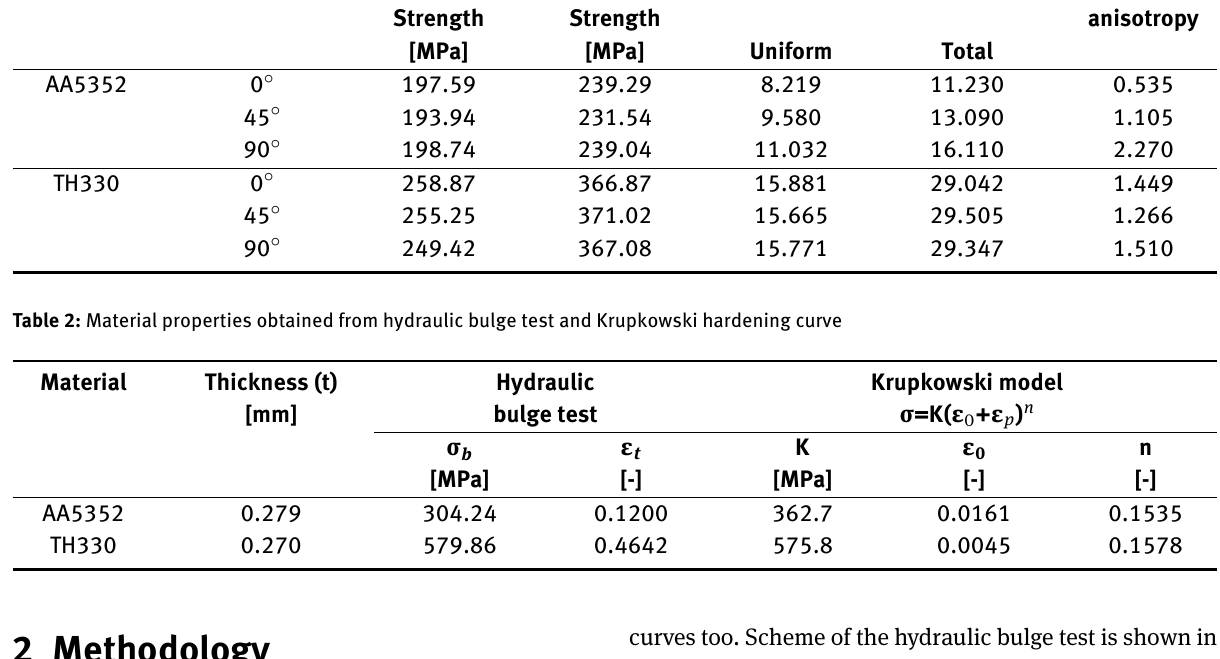
Table 1: Basic mechanical properties of studied materials Material